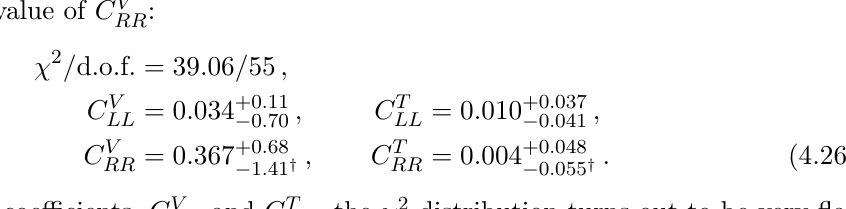
Figure 6 . Fit-independent plot of Scenario 6 , showing the regions allowed at 1 (cid:27) (dark colours), for di(cid:11)erent values of C T . There is no allowed region for (cid:22) F D (cid:3) RR areas correspond to the more relaxed 30% bound on the leptonic B c decay and the 2 (cid:27) region for (cid:22) F D (cid:3) , L